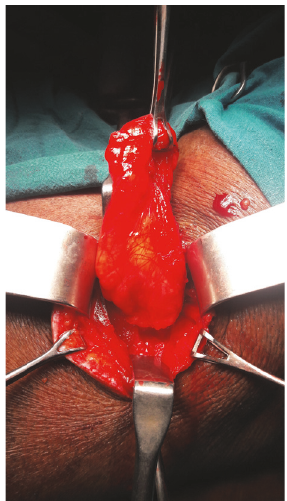
Figure 2: Retroperitoneal fat dissected out up to the defect.